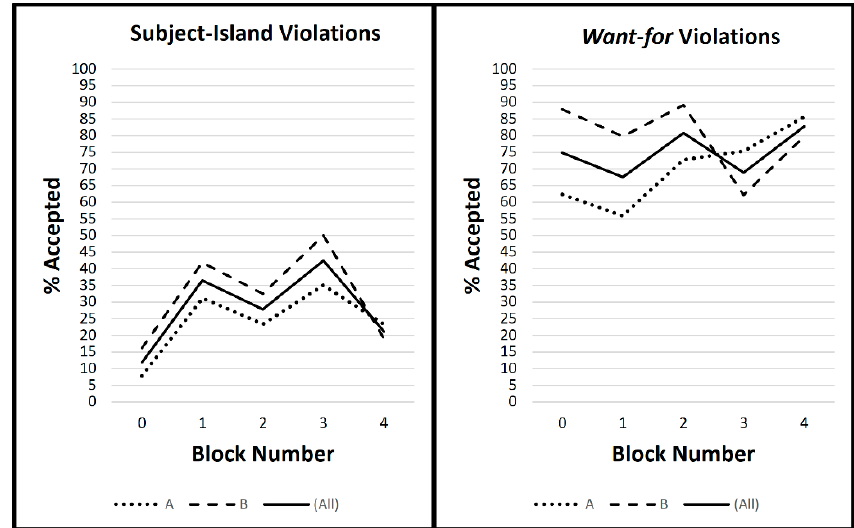
Figure 10. Experiment III, Subject-Island and Want-for violations.